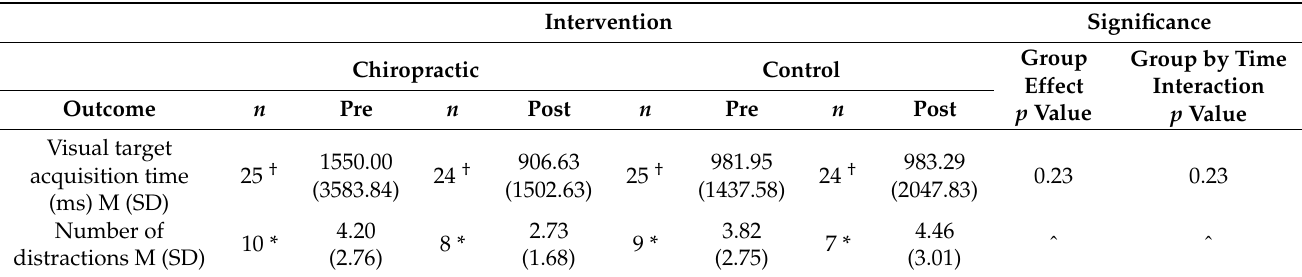
Table 2. Target task outcome measure results of the study participant’s pre- and post-chiropractic intervention versus active control.